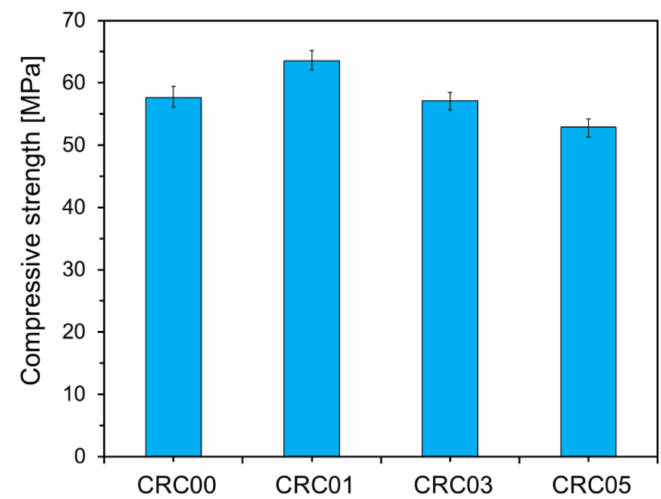
Figure 8. The compressive strength of CNT-reinforced cement